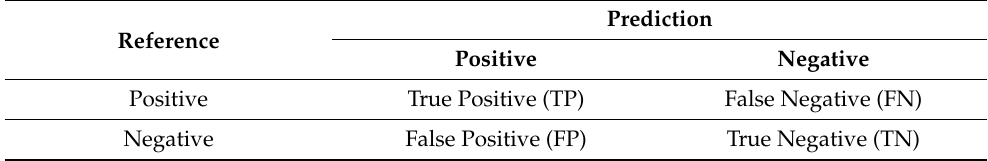
Table 1. Confusion matrix applied in load